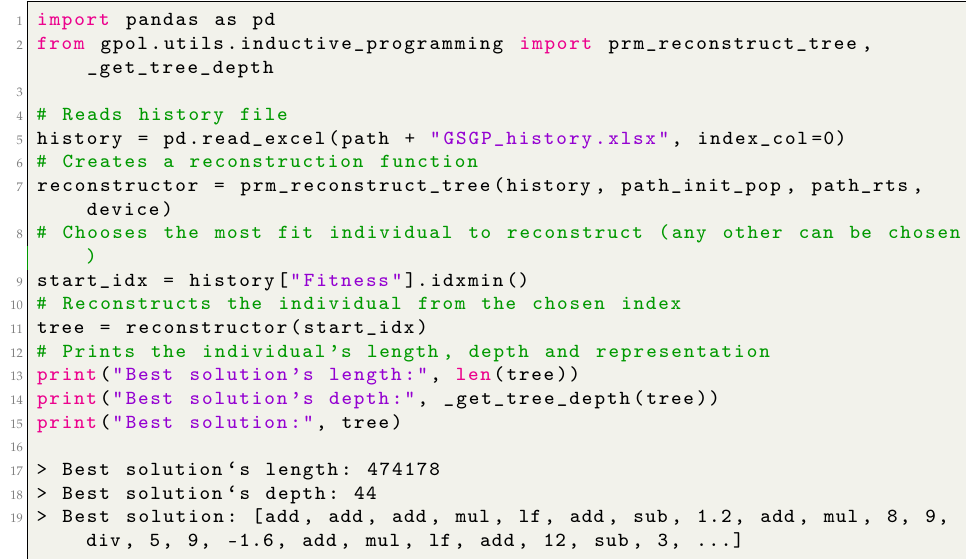
Figure A9. An example of GSGP’s reconstruction.